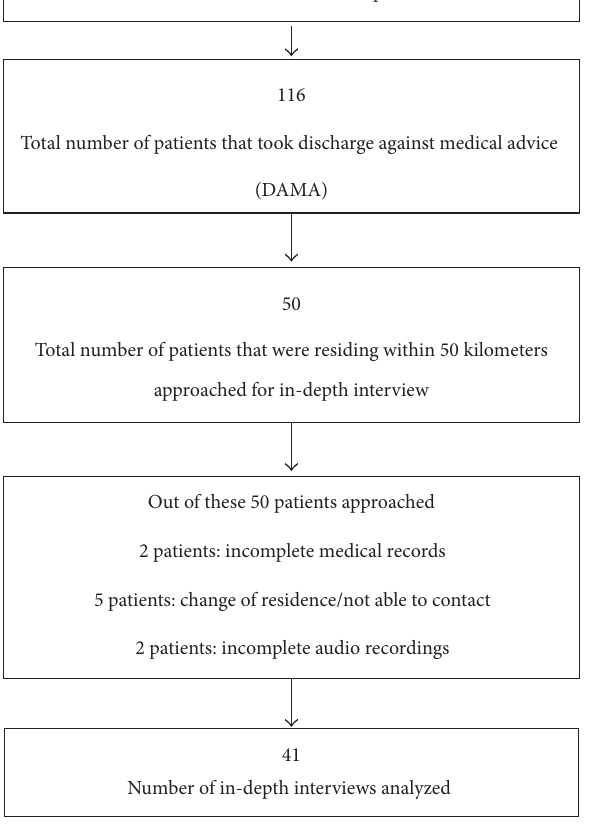
Figure 1: Flowchart of study population.